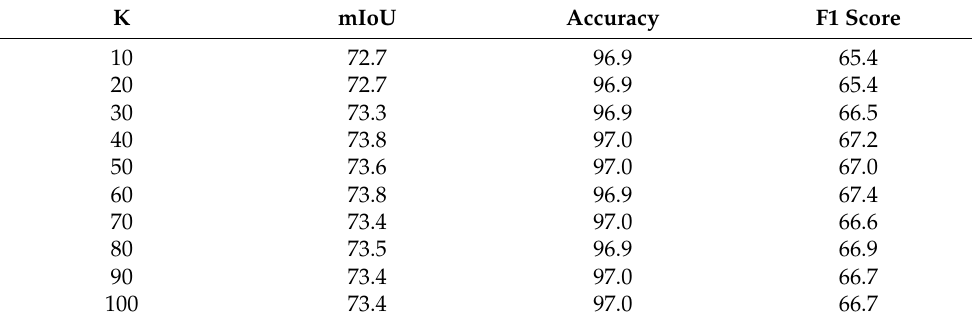
Table 4. The results of PSPNet with different K values on Massachusetts Roads Dataset.